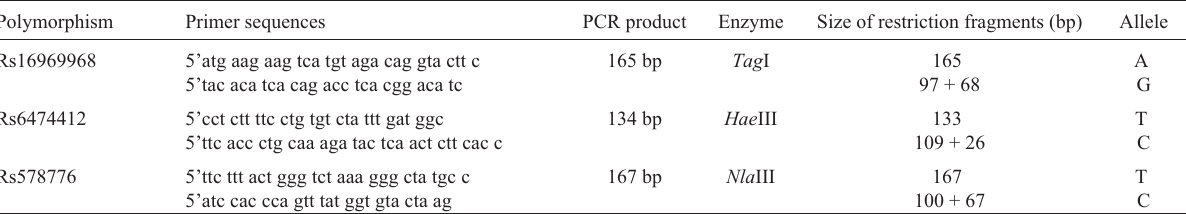
Table 1 - Genotyping details for analysis of SNPs of interest.